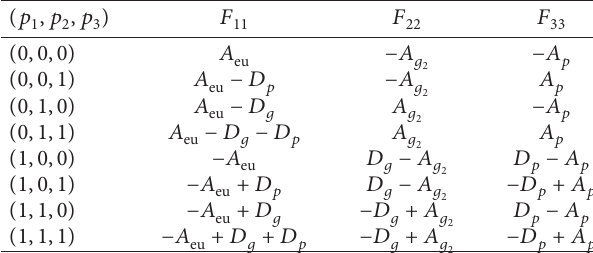
Table 3: The main eigenvalues for the equilibrium